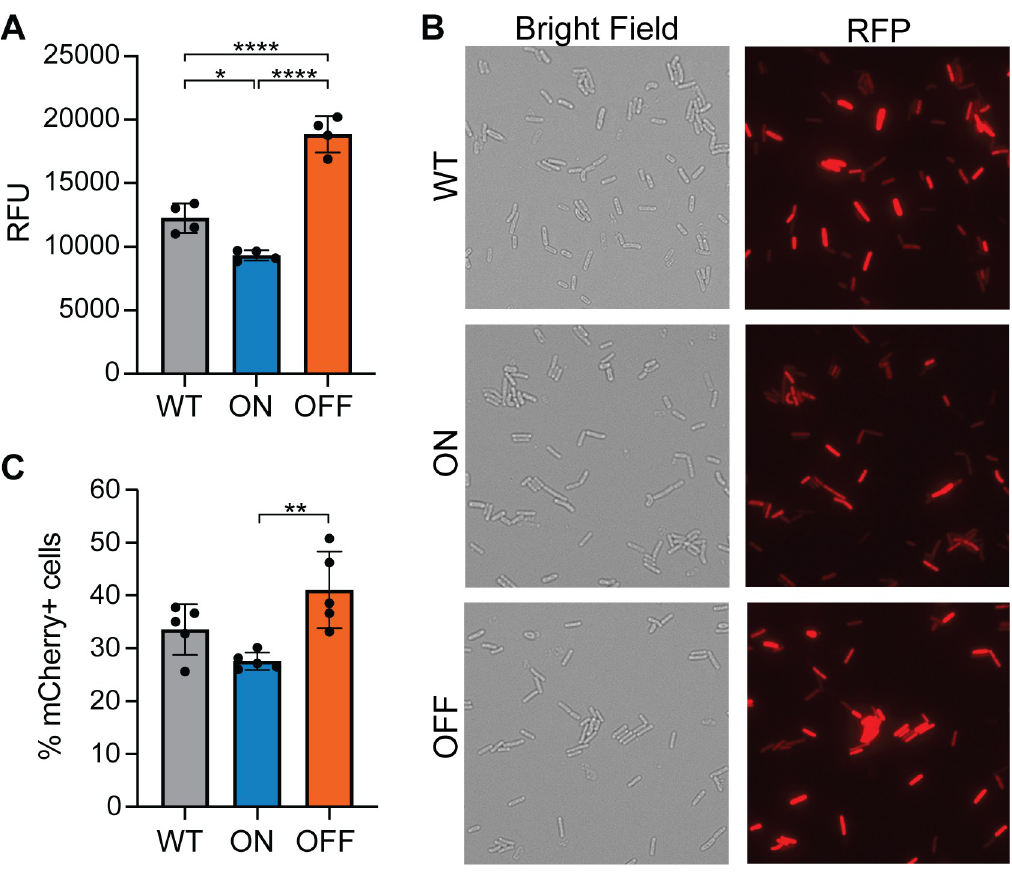
Fig 4. Phase variation of PdcB modulates c-di-GMP at the population and single-cell levels. (A) Measurement of c-di-GMP using the pPRS::mCherry reporter in R20291 (WT), pdcB Δ 3-ON, and pdcB Δ 3-OFF. Relative Fluorescence Units (RFU) calculated from arbitrary fluorescence units after 180 minutes RFP maturation normalized to OD 600 at time 0. Kinetic analysis of fluorescence and data for the pPRS A70G ::mCherry controls are in S2 Fig. (B) Representative micrographs showing heterogeneity in fluorescence in the above strains. (C) Number of mCherryOpt-expressing cells determined by flow cytometry expressed as a percentage of total Syto-9 stained cells. (A,C) Bars indicate means and standard deviations, with circles indicating values from independent biological samples. � p < 0.05, �� p < 0.01, ���� p < 0.0001 by one-way ANOVA and Tukey’s